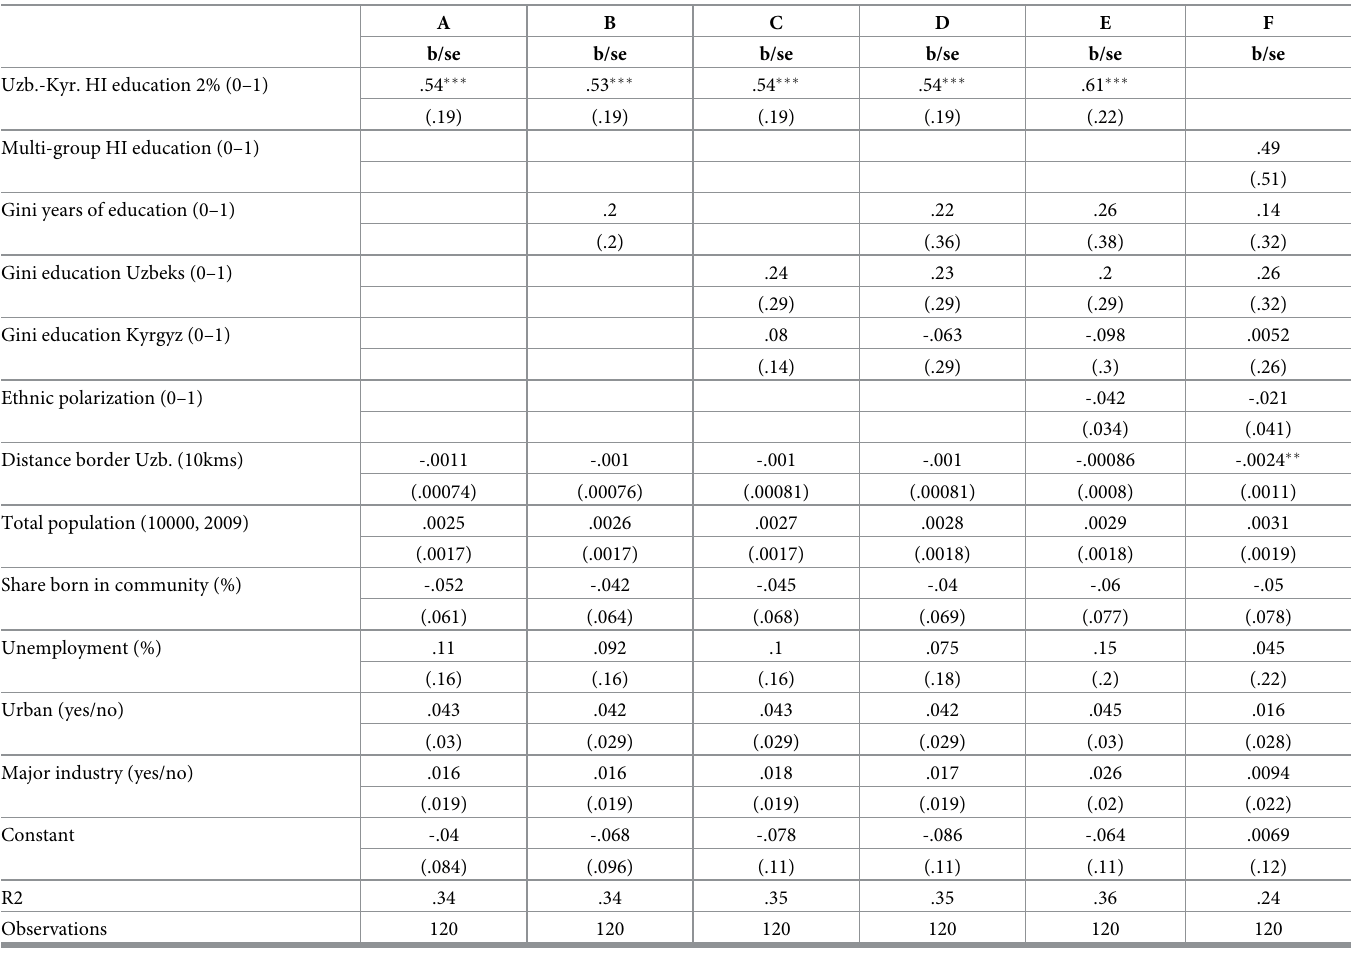
Table 3. Forced displacement in